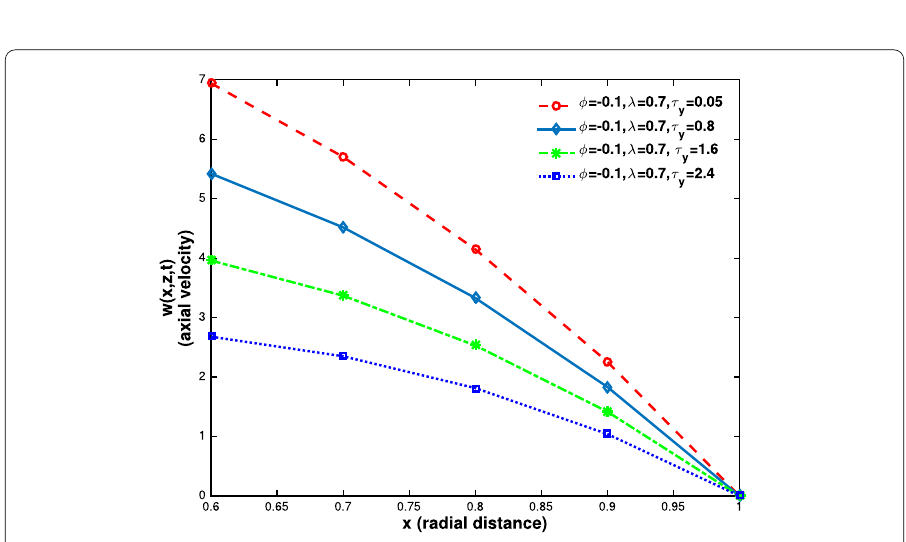
Figure 23 Axial velocity vs radial distances (near wall) for varying yield stress at z = 28, t = 0.45, K = 1.6, φ = –0.1, λ = 0.7